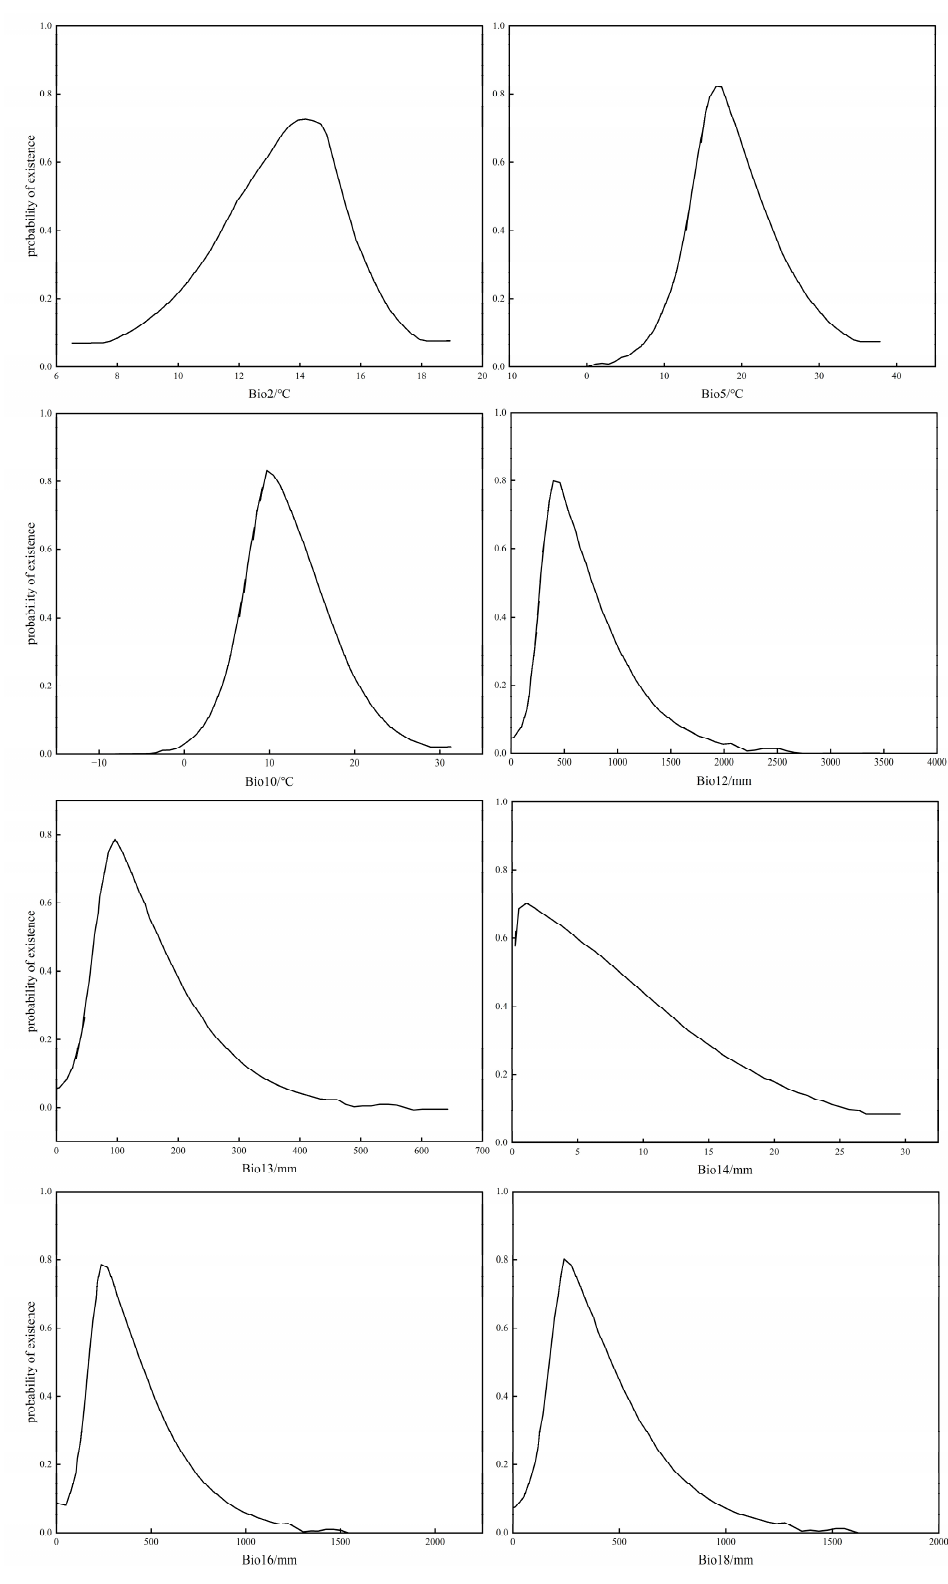
Figure 4. Probability response curves of the main climatic factors.